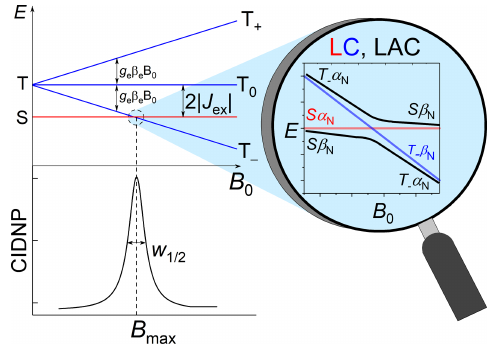
Figure 1. Energy levels diagram of a biradical or radical pair with negative exchange interaction and the level anti-crossing (LAC) mechanism explaining the resulting dependence of CIDNP on the magnetic field.